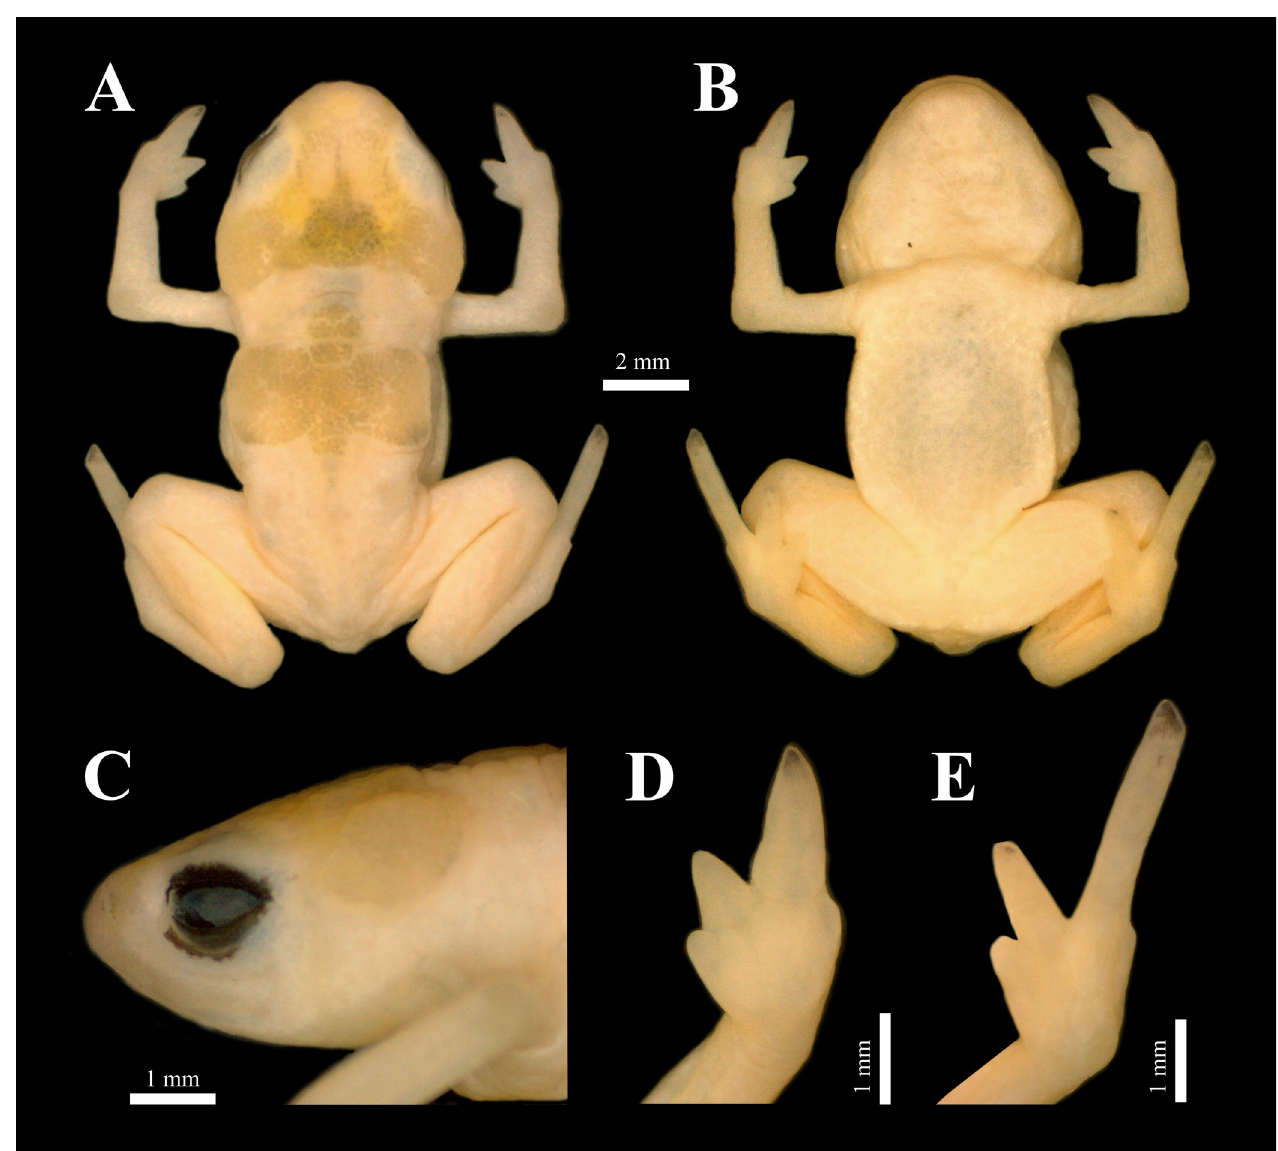
Fig 1. Brachycephalus rotenbergae sp. nov., holotype (HCLP-A 260, adult male, SVL = 13.5 mm). (A) Dorsal view, (B) ventral view, (C) lateral view of head, (D) ventral view of hand, (E) ventral view of